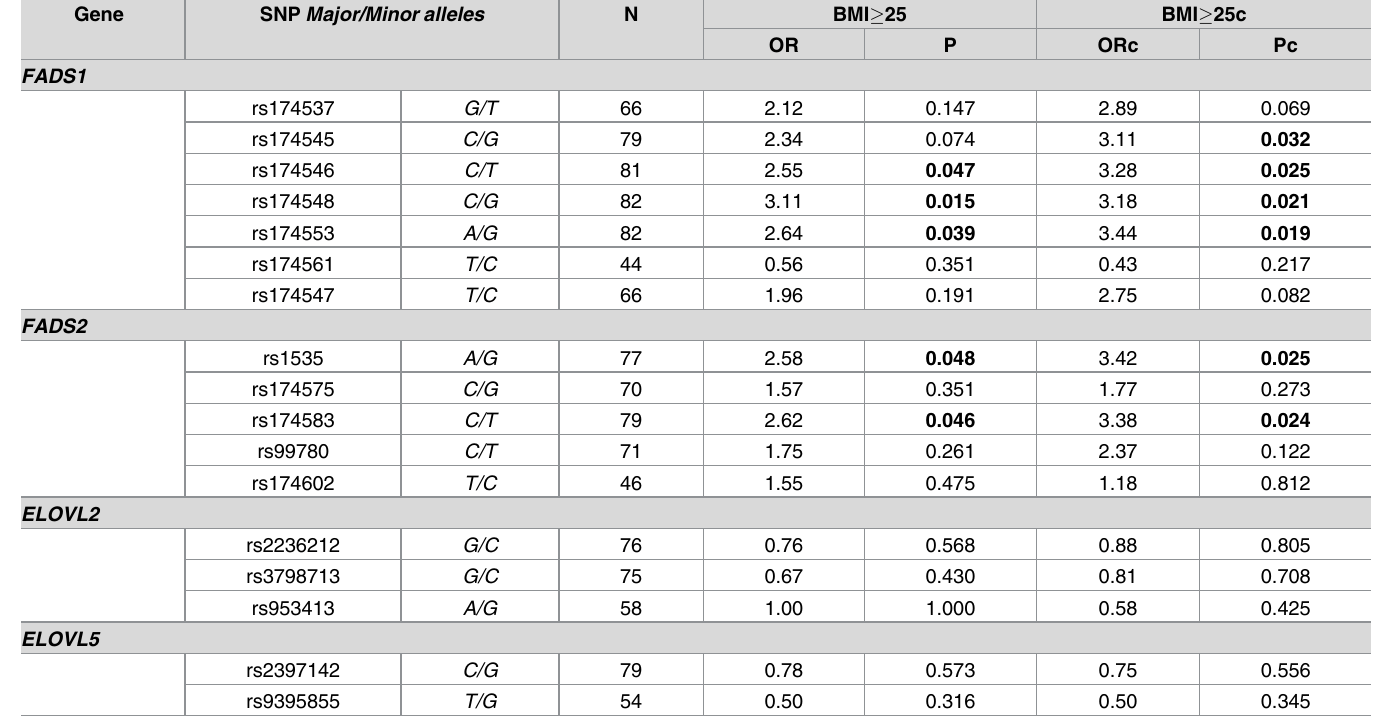
The association between SNPs and obesity risk was analyzed with logistic regression. SNPs were coded according to minor allele count and analyzed as numeric variable. BMI = Body Mass Index. OR = odds ratio per minor allele with the major allele as reference. ORc and Pc = are corrected values after adjustment for age, education, smoking and energy intake. Nominal associations are highlightedin bold (p <